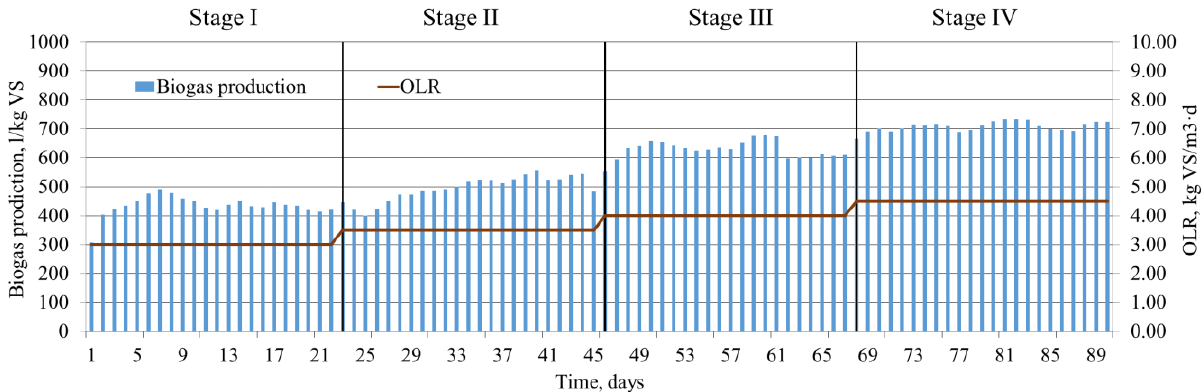
Figure 2. Daily biogas production at different OLRs.